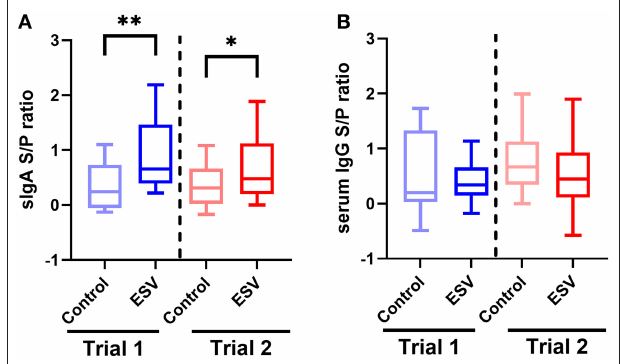
FIGURE 1 | ESV antigen-specific ELISA S/P ratios from vaccinated pregnant sows in Experiment 1. (A) Secretory IgA S/P ratio in colostrum. (B) IgG S/P ratio in serum. Control—commercial IM E. coli vaccination. Experimental subunit vaccine (ESV)—intranasal vaccination. * P < 0.05 and ** P < 0.01 ( n = 20 sows/group/trial).